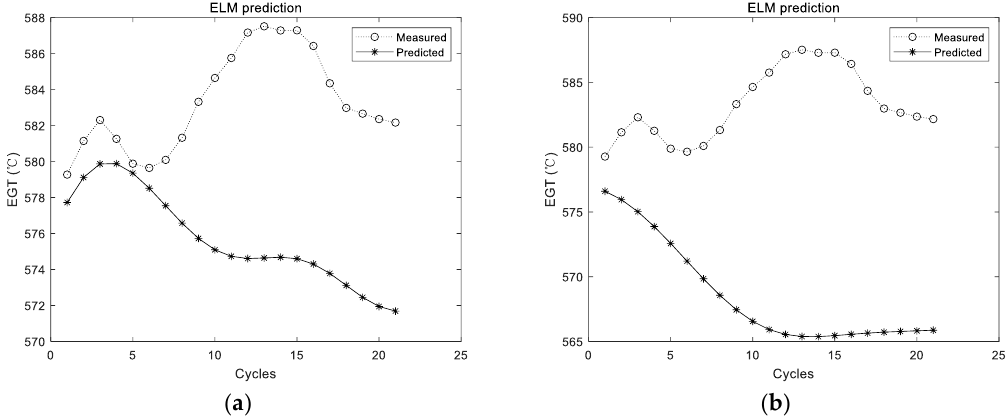
Figure 9. Experimental results of ELM prediction using the third group of data. ( a ) The first experimental results; ( b ) the second experimental results.